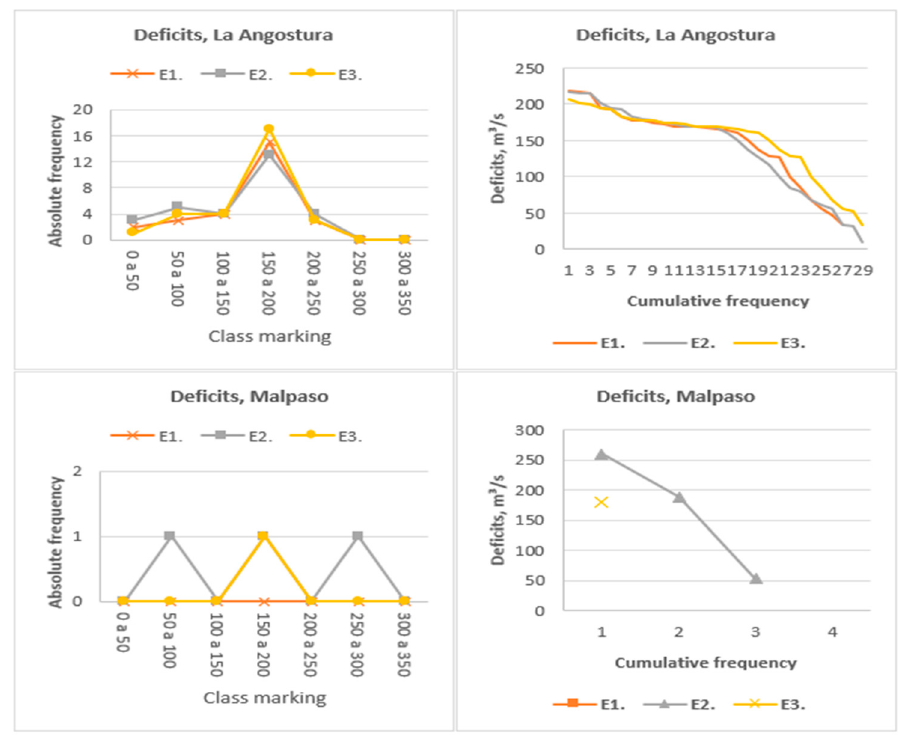
Figure 10. Deficit count in the policies tested for La Angostura dam and Malpaso dam.